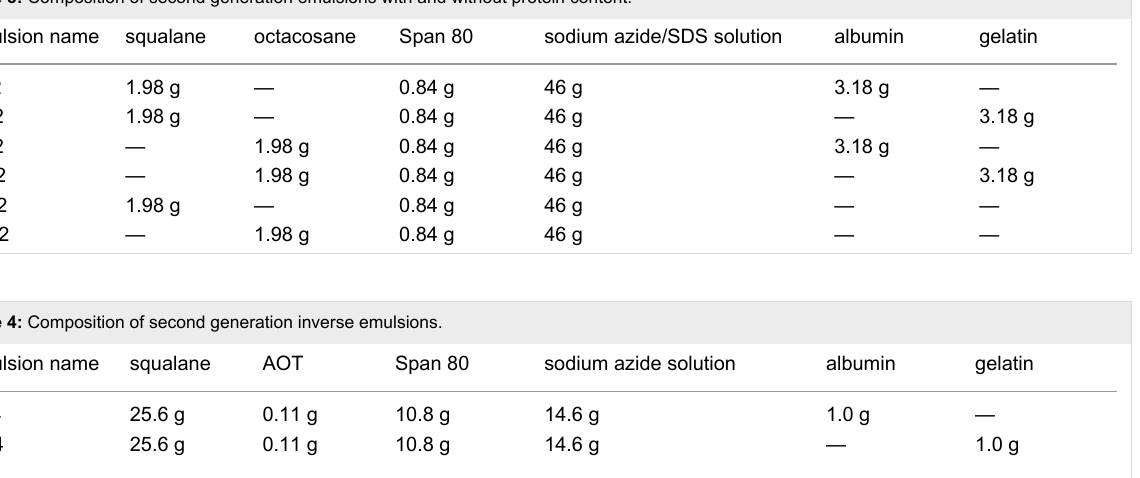
Table 3: Composition of second generation emulsions with and without protein content.